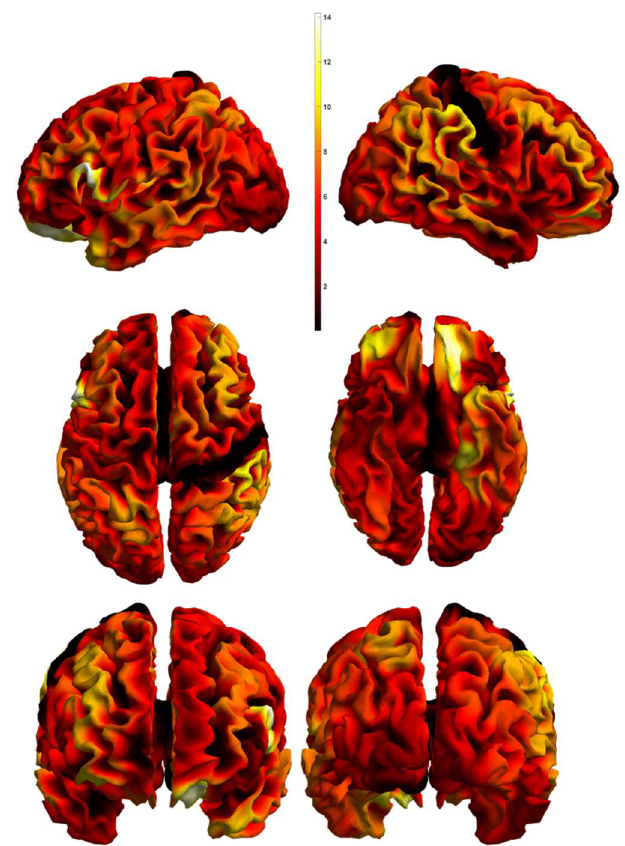
Figure 1. Multivariate Statistical Maps. 3D mesh projections of the Chi statistics testing the signifi- cance of the differences between the diagnostic groups. The top row shows the left and right views, the middle row shows the top and bottom view, and the bottom row shows the front and rear views.